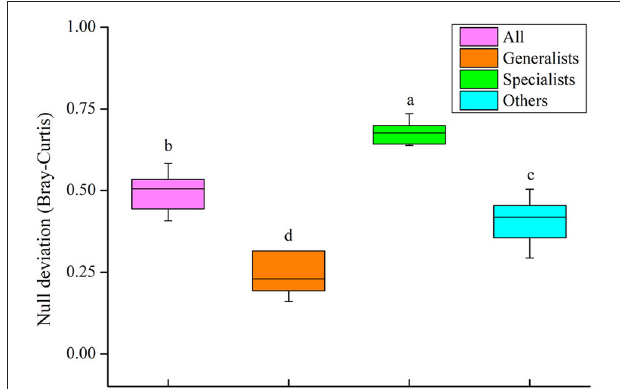
FIGURE 9 | Plots showing the null deviation of soil bacterial community (all) and three subcommunity (generalists, specialists and other taxa). A null deviation close to zero suggests that stochastic processes are more important in structuring the community, whereas larger positive or negative null deviations suggest that deterministic processes are more